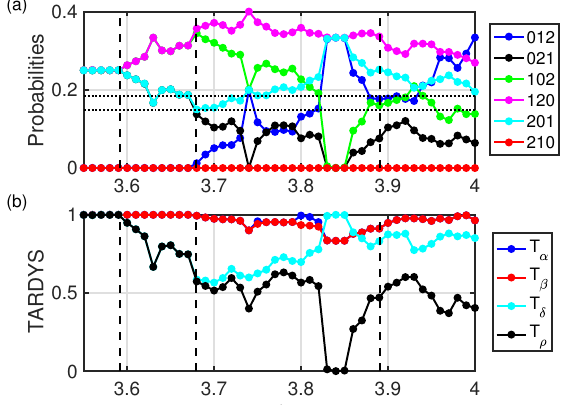
Figure 4. ( a ) Word probabilities for the logistic map. ( b ) TARDYS quantifiers for the logistic map. Vertical lines indicate the regions with different constraints in the probabilities of the words (see main text).